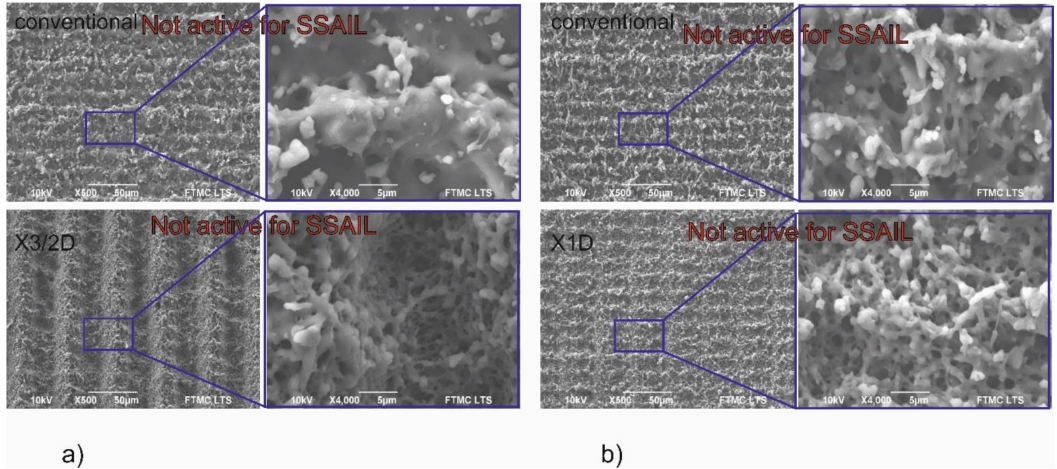
Figure 11. SEM image of PC / ABS surface treated with picosecond laser applying ( a ) 20 W and ( b ) 15 W average laser power. “Conventional”, “X3 / 2D” and “X1D” indicate the method of laser writing, as described in the experimental